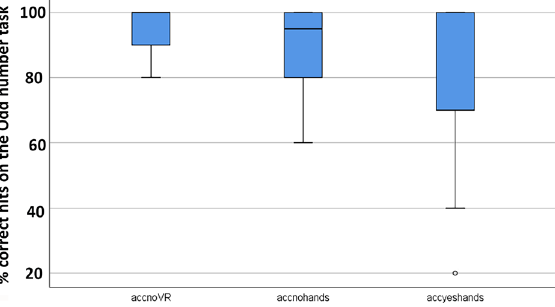
Figure 7. Compared to passive VR, interactive avatar VR significantly reduced participants’ accuracy on an attention demanding